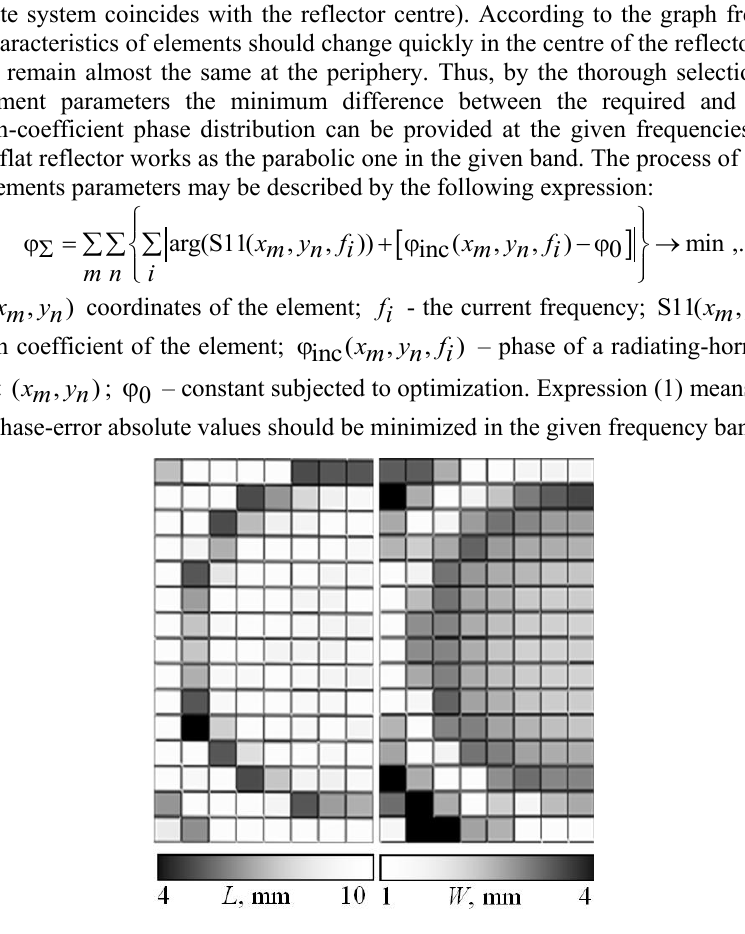
Fig. 5. A half of synthesized reflector for the two-layer offset reflectarray: on the left - distribution of the slot length; on the right - distribution of the slot